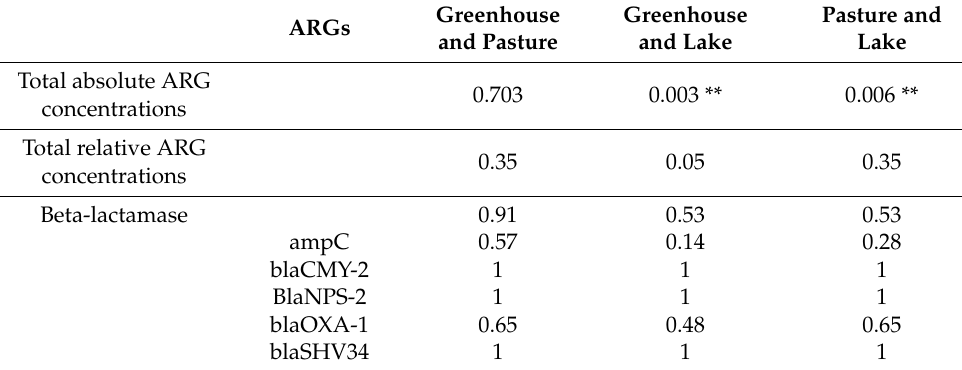
Table 1. p values of pairwise comparisons using Dunn (cid:48) s test as the post hoc test of the Kruskal– Wallis test for evaluating differences between each pair of land use types. The absolute and relative concentrations of all ARGs, and the relative concentration of each class of ARGs and each ARG were included. p values were corrected for type I errors using